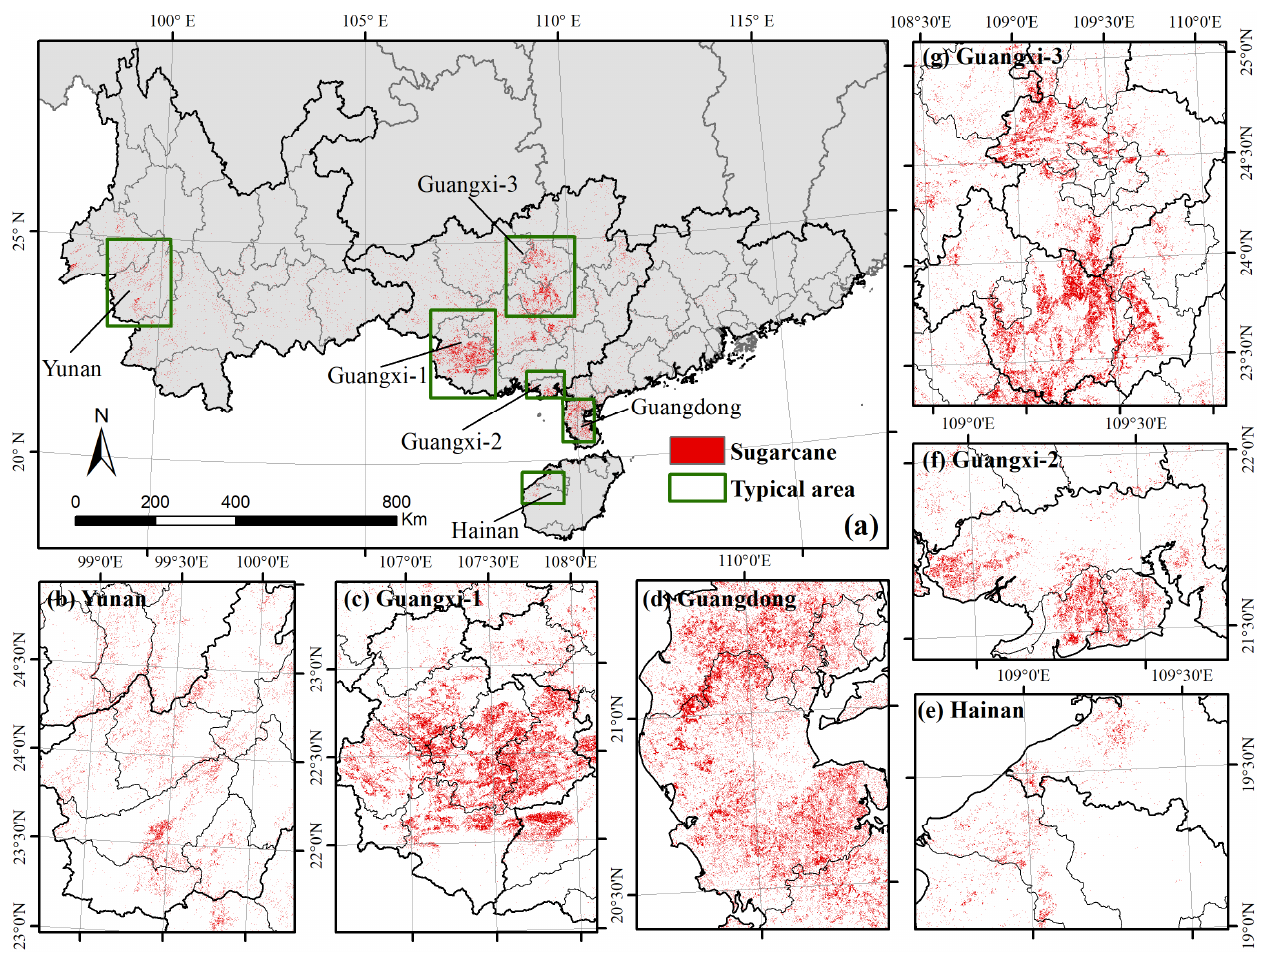
Figure 6. Sugarcane identification map derived from SR data in China in 2019. ( a ) Sugarcane map in China; ( b – g ) zoomed-in areas of the typical areas in subfigure ( a ). Table 1. Confusion matrix of the sugarcane identification maps in China in 2019 derived from SR and TOA